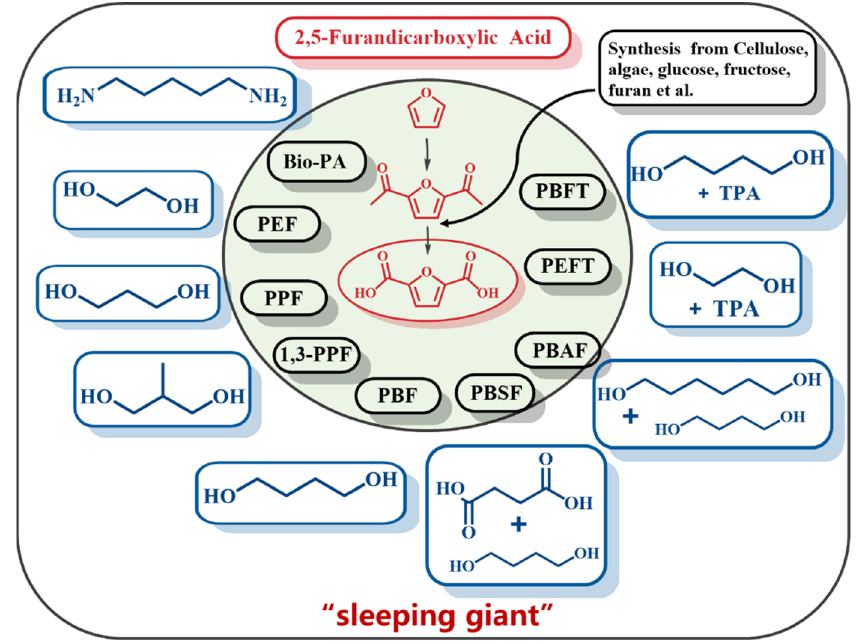
Figure 1. Different polyesters derived from 2,5-FDCA.